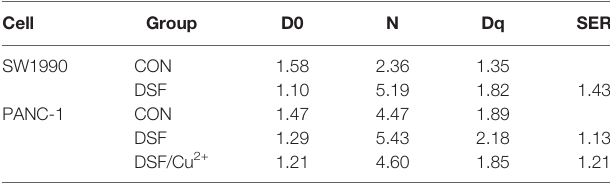
TABLE 4 | The D0, N, Dq and SER values of cells treated with DSF and DSF/ Cu 2+ . The SER value was simulated using the multi-target single hit model.